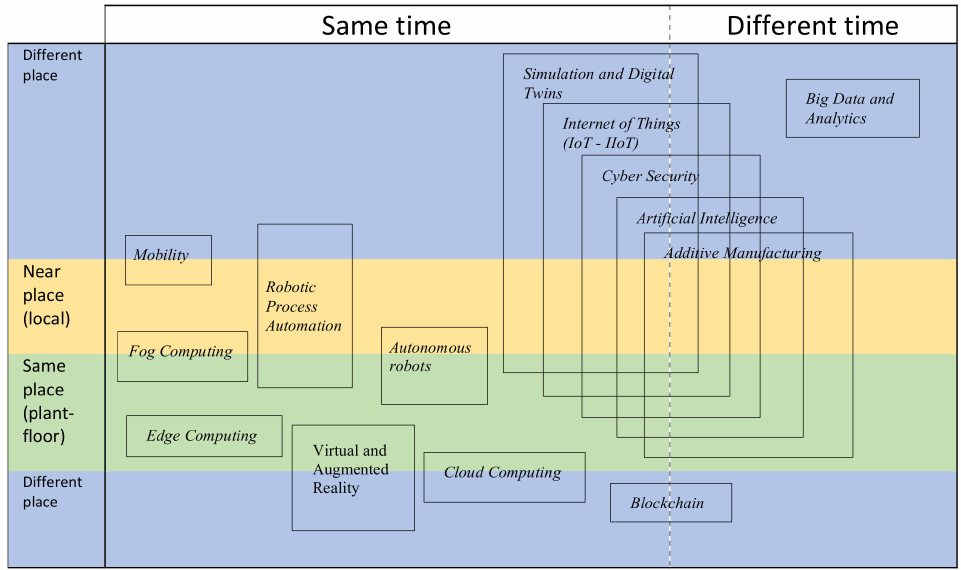
Figure 11. Proposed CSCW matrix for Industry 4.0 paradigms and key